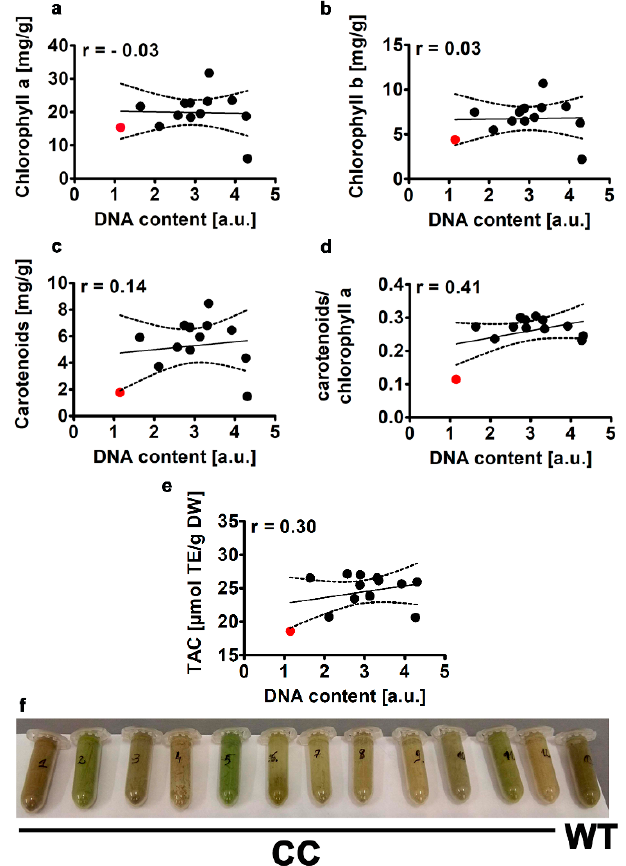
Figure 5. Colchicine and cytochalasin B-mediated effect on the levels of chlorophyll a ( a ), chlorophyll b ( b ), carotenoids ( c ) carotenoids to chlorophyll a ratio ( d ) and total antioxidant capacity (TAC) ( e ) in the microalga Planktochlorella nurekis . Correlation analysis between chlorophyll a ( a ), chlorophyll b ( b ), carotenoids ( c ) and carotenoids to chlorophyll a ratio ( d ), TAC ( e ) and DNA content. Twelve CC-treated clones were considered (black dots). WT cells are denoted as a red dot. Results represent the mean from three independent experiments. The levels of pigments and TAC were calculated per g of dry weight. The 95% confidence interval is shown. Correlation analysis of the data was performed using a Linear Correlation (Pearson r) test. The color of dry biomass of twelve CC-treated clones (1–12) and WT cells (13) is also shown ( f ). DW, dry weight.